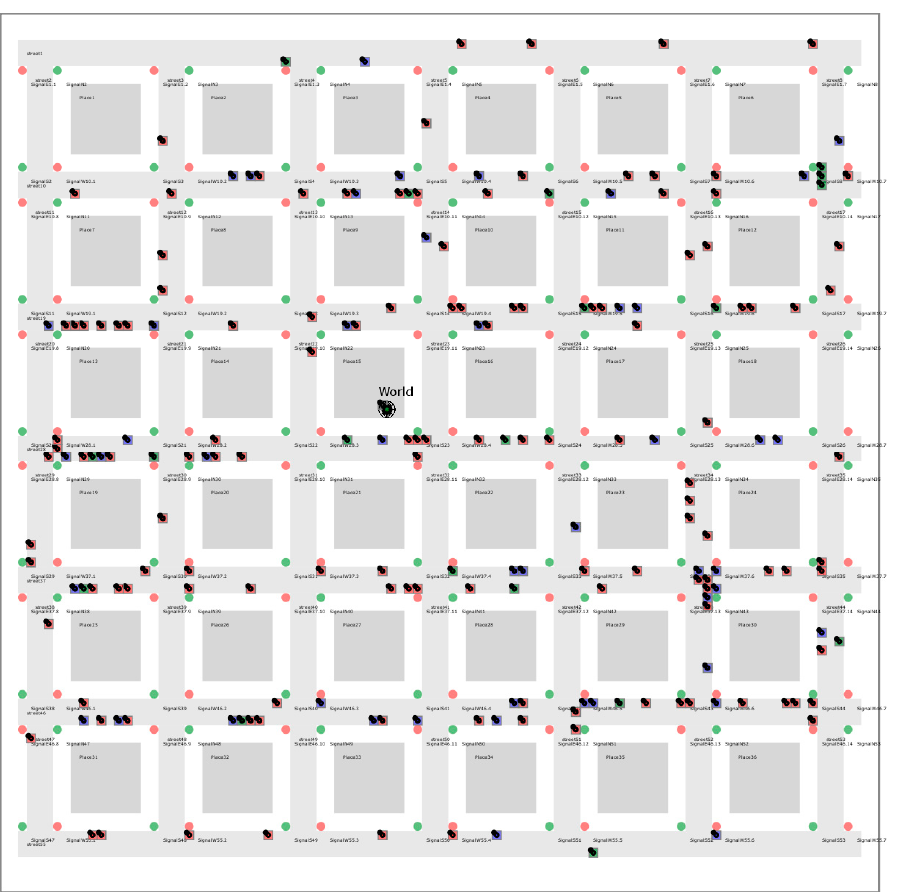
Figure 13. A typical simulation world consisting of a street map, traffic signals, places, and different vehicle classes (red: individual, blue: shared, and green: public).